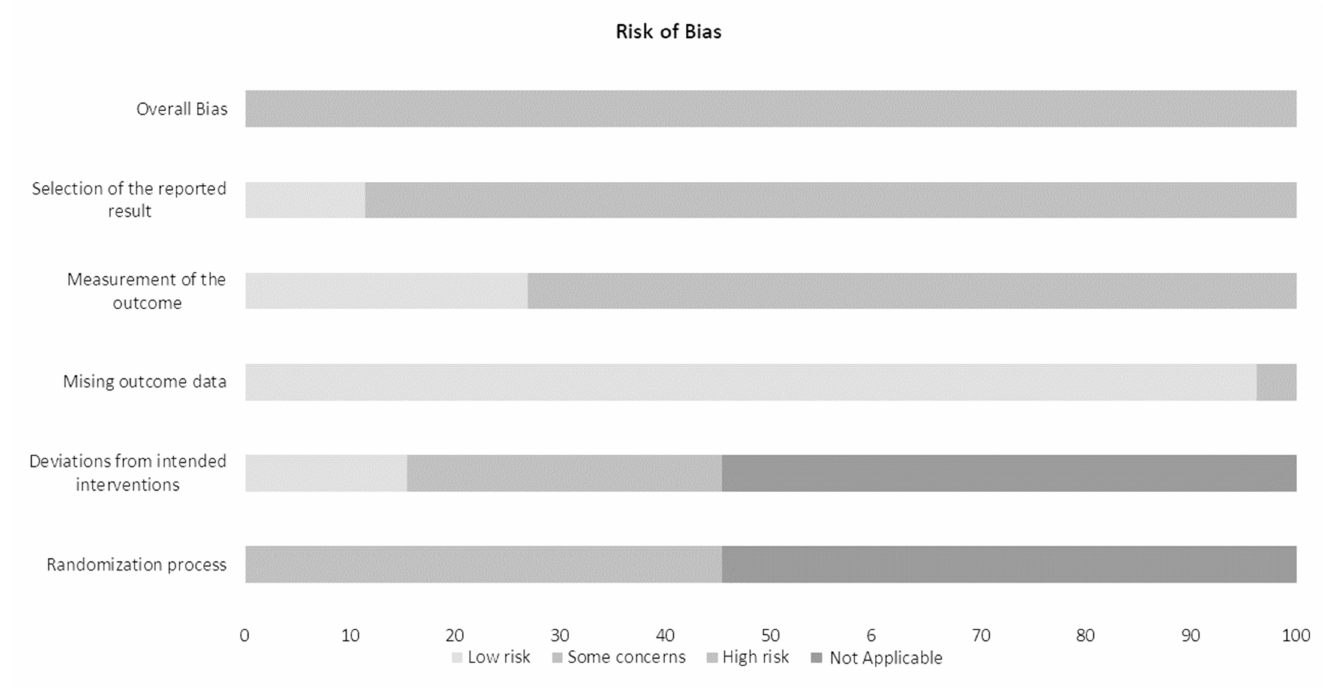
Figure 2. Risk of